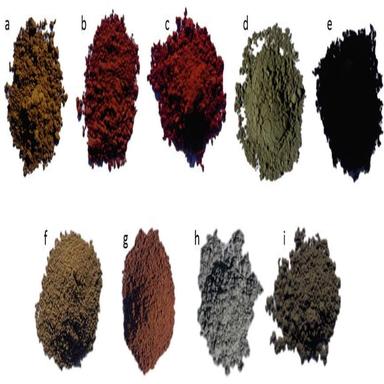
Analysed samples. a) Natural Sienna (TR/0262); b) burnt Sienna (TR/0263); c) red earth from Pozzuoli (TR/0318); d) green earth (TR/0283); e) burnt shadow earth from Cyprus (TR/0271); f) GBW-07404; g) GBW-07405; h) Granodiorite JG-3; i) NIST-SRM 2586. (For interpretation of the references to colour in this figure legend, the reader is referred to the web version of this article.)